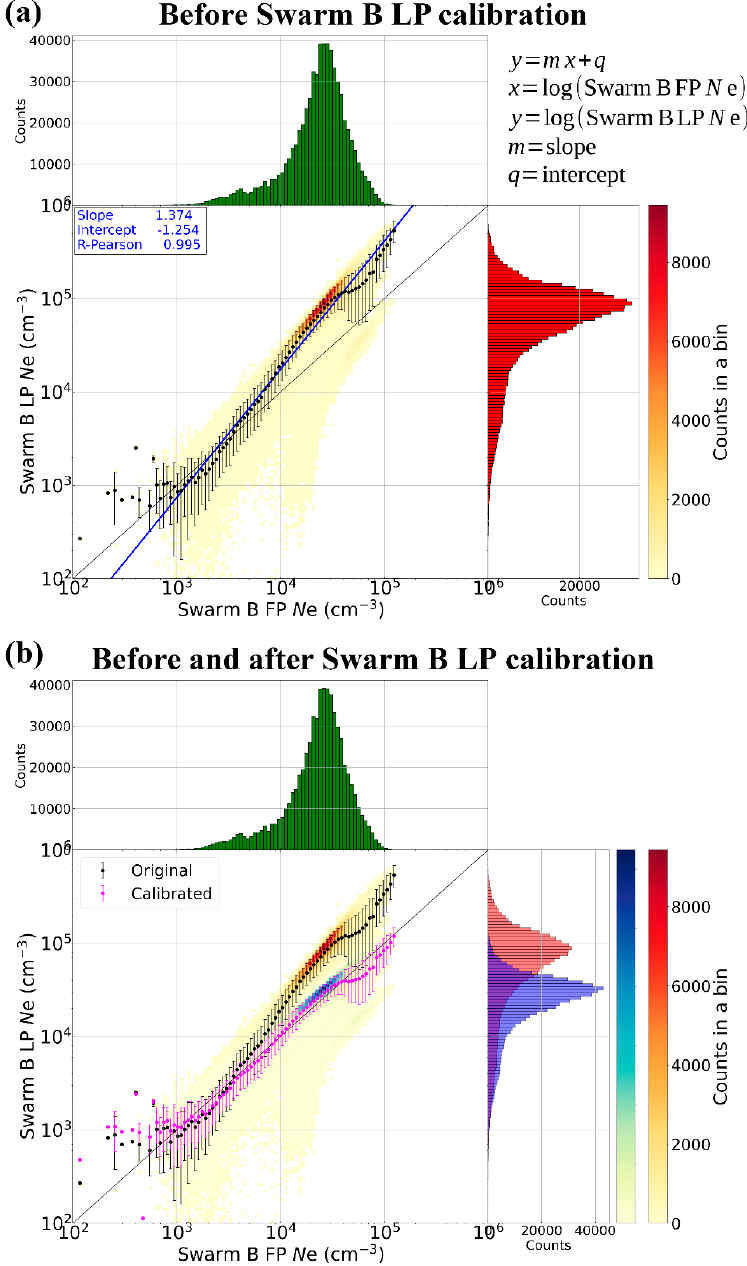
Figure 2. JPDs between Swarm B LP N e observations ( y -axis) and Swarm B FP N e observations ( x -axis), both recorded from 1 January 2019 to 30 September 2021 in the range of latitudes between 70 ◦ S and 70 ◦ N for the nighttime sector (01:00 − 03:00 LT). Panel ( a ) refers to Swarm B LP observations before the calibration, while Panel ( b ) also shows the distribution of Swarm B LP observations after applying the calibration. In each panel, histograms of the counts are also reported: on the right and in red for Swarm B LP before the calibration, in blue for Swarm B LP after the calibration, and on the top and in green for Swarm B FP. The black dots refer to the mean values of original Swarm B LP N e observations conditioned by Swarm B FP N e observations, with the corresponding standard deviation as error bar. The magenta dots refer to the mean values of calibrated Swarm B LP N e observations conditioned by Swarm B FP N e observations, with the corresponding standard devia- tion as error bar. The blue line in Panel ( a ) is the linear fit on black dots, with coefficients given in the legend. The thin black line is the first-third quadrant bisector.